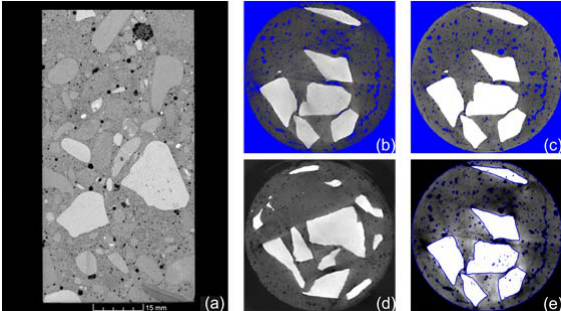
Figure 5. CT scans of concrete samples: (a) raw cross sectional image of in ‐ situ casted concrete, (b) insufficient and (c) optimal beam hardening correction for threshold based segmentation, (d) shadowing effect due to insufficient radiation through dense particles, and (e) gradient map as a starting point for the watershed